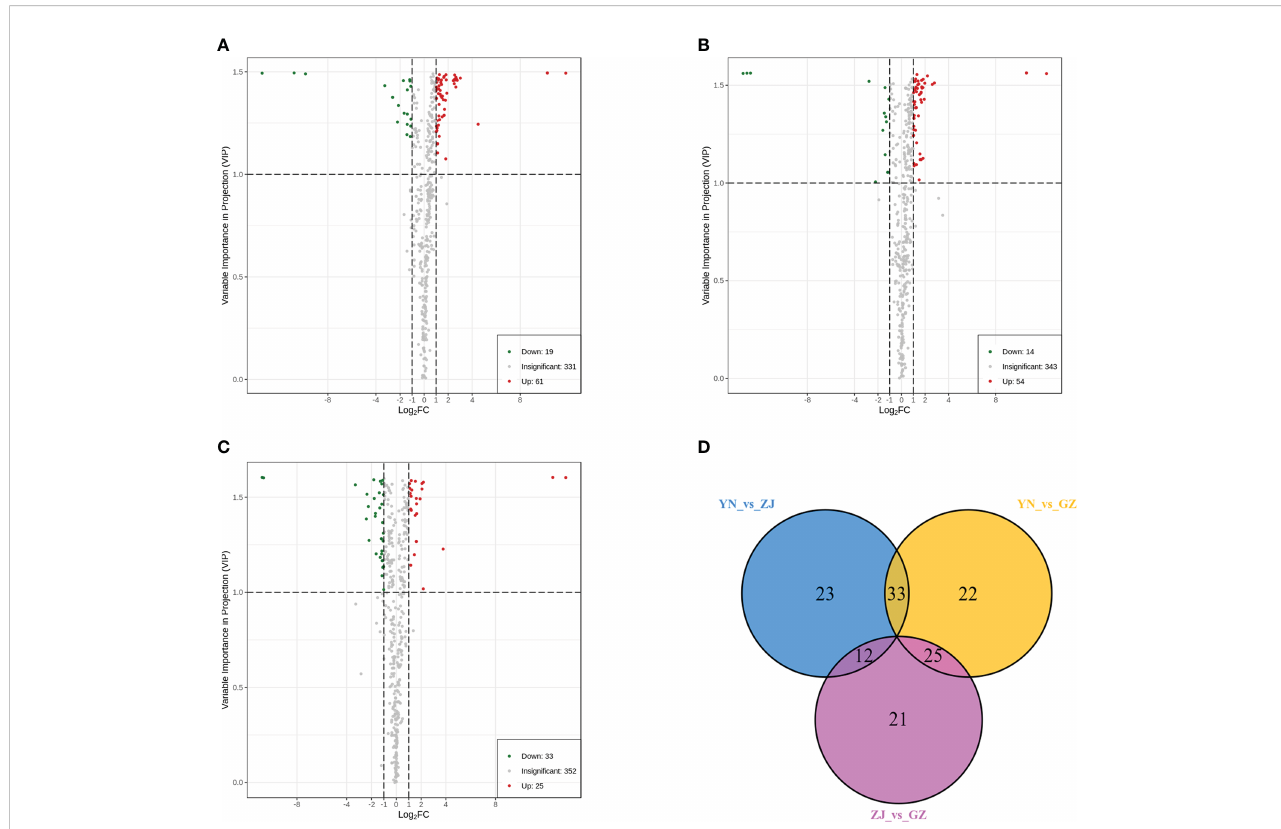
FIGURE 4 Volcano maps and venn diagram analysis of differential metabolites for three comparison groups (YN vs. GZ, YN vs. ZJ, ZJ vs. GZ). Differential metabolite analysis of Dendrobium of fi cinale from different provenances. (A – C) Volcano maps of differential metabolites in different pairwise comparisons: (A) YN vs GZJ; (B) YN vs ZJ; (C) ZJ vs GZ. (D) Venn diagram shows the overlapping and unique metabolites amongst the comparison